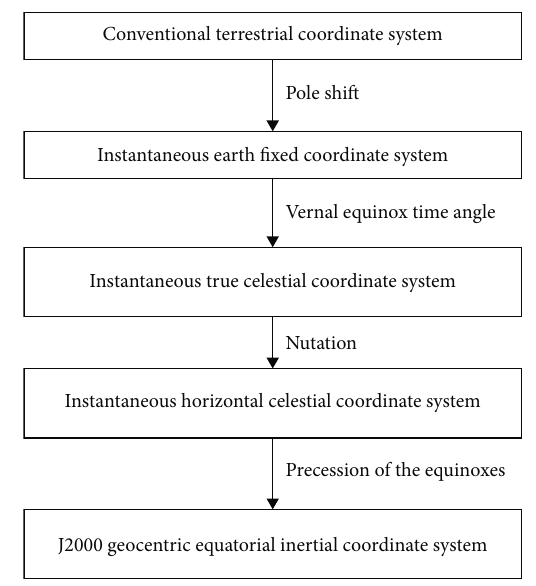
Figure 2: Schematic diagram of the conversion process between the J2000 coordinate system and WGS84 coordinate